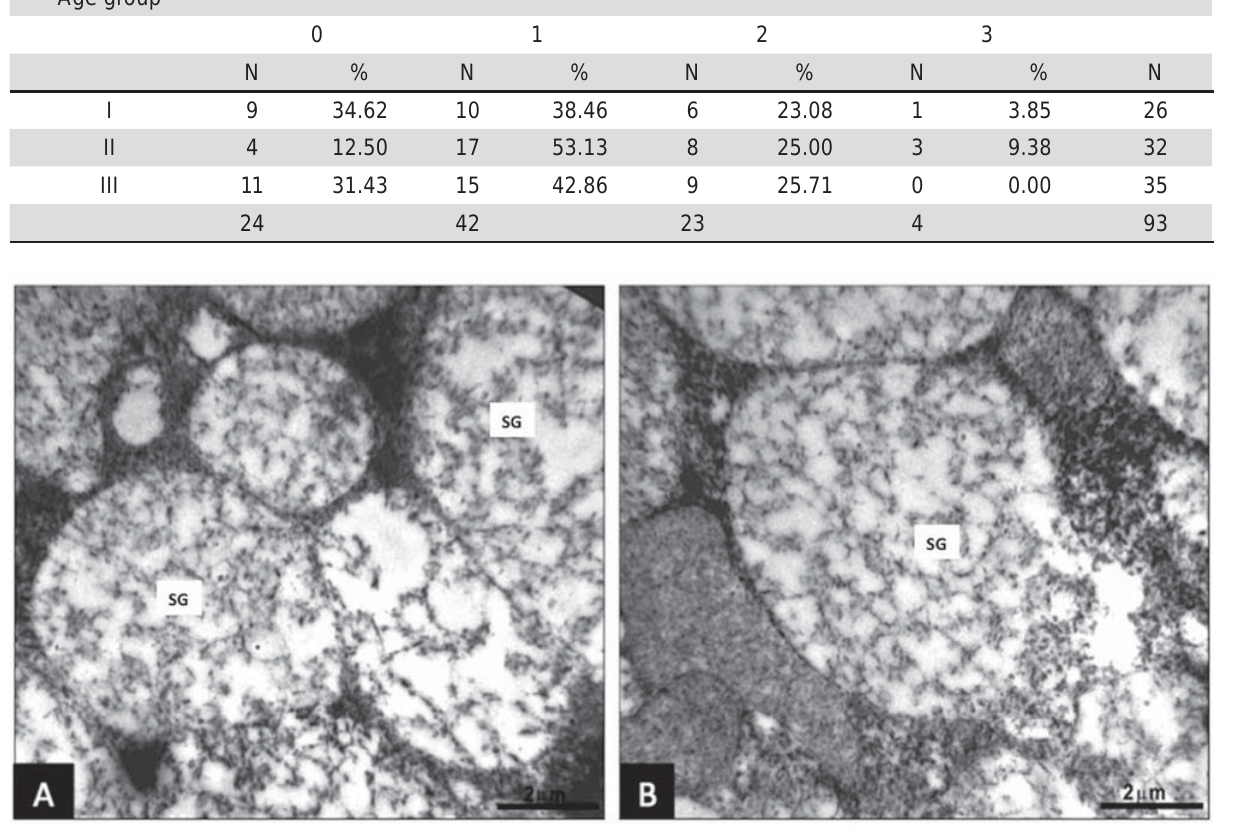
Figure 5- Transmission electron microscopy (TEM) of a human sublingual gland with advanced autolysis (male, 71 years old). A: Secretion granules (SG) of mucous cells with partially degraded content; B: Secretion granules (SG) with membrane rupture and degradation of